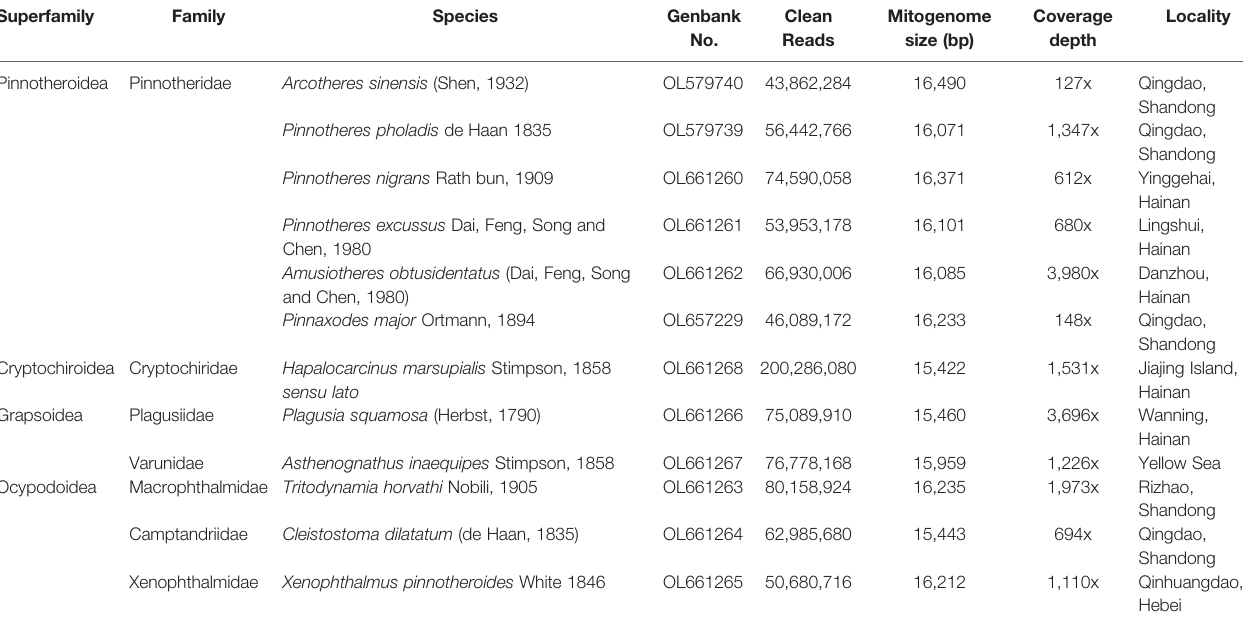
TABLE 1 | New mitochondrial genomes analyzed in the present study. Superfamily